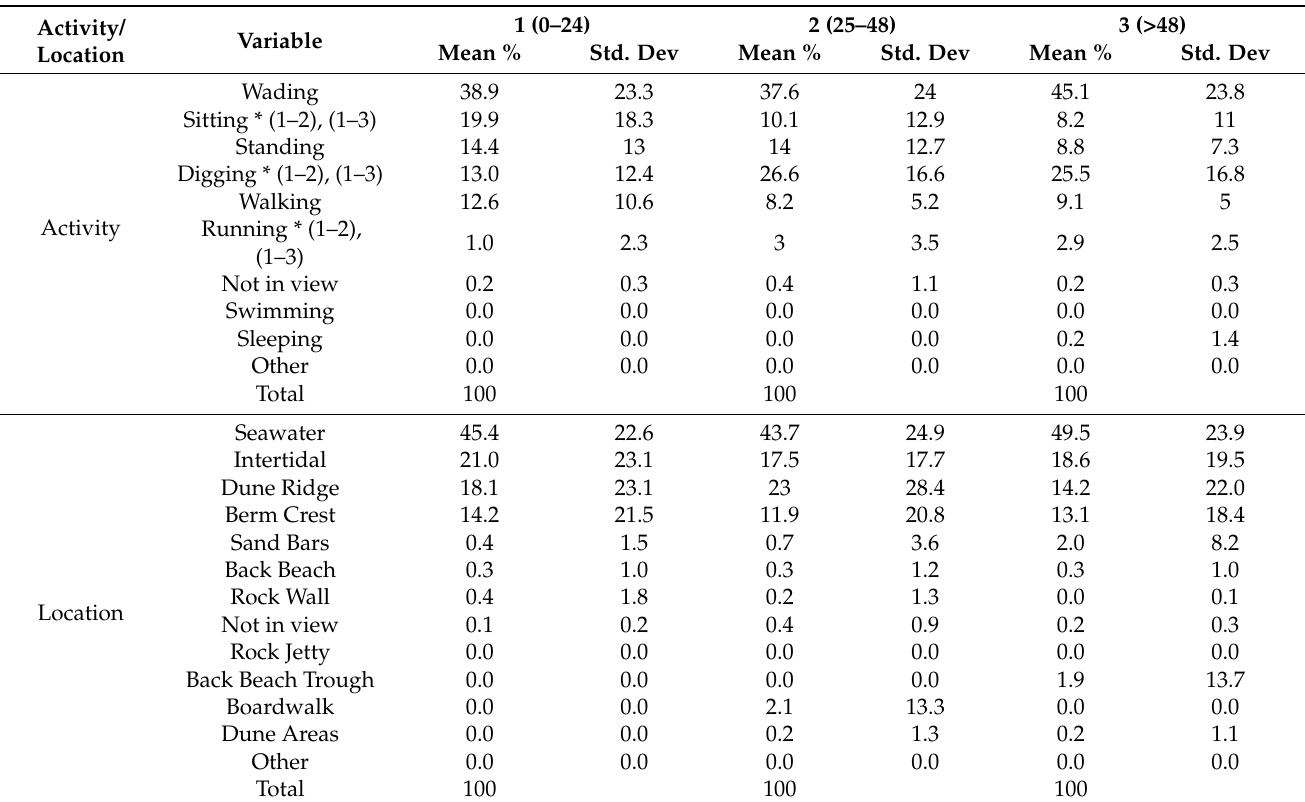
Table 4. Mean Percent Time Spent Engaged in Various Activities and Locations by Age Groups, 1–3 (for 0–24 months, n = 27, for 24–48 months, n = 41, and for >48 months, n = 52).